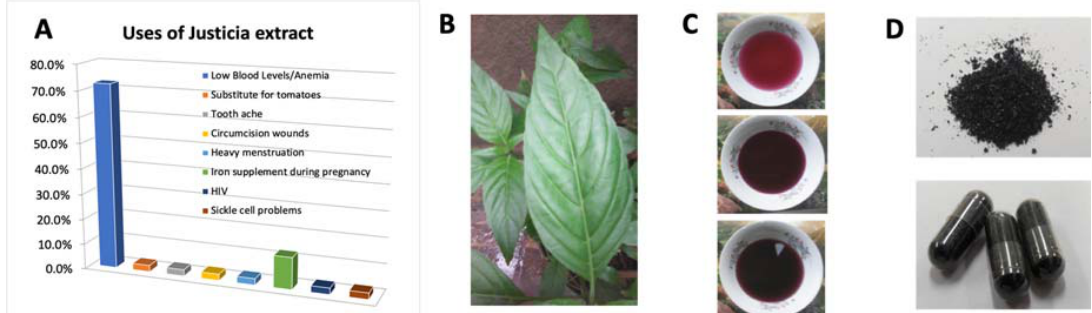
Figure 1. ( A ) Results from survey of plant extract use; ( B ) photo of Justicia leaves, ( C ) extract from leaves; ( D ) lyophilized powder from isolated leaves extract.